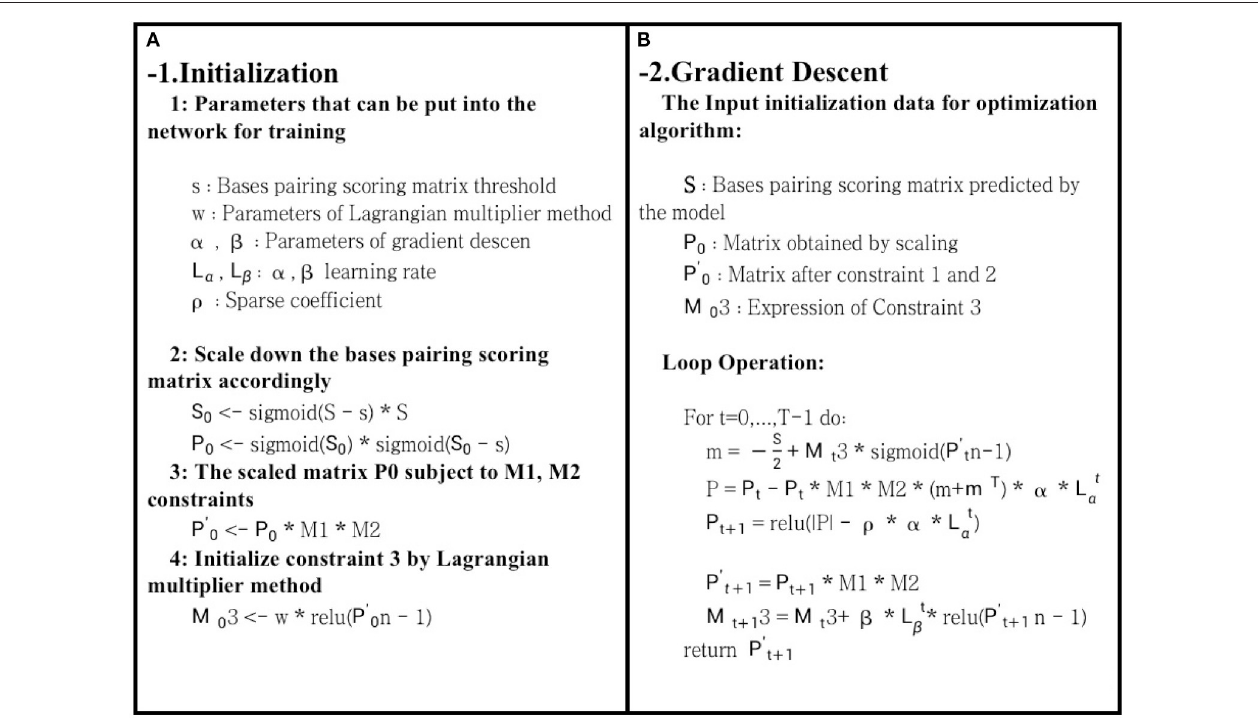
FIGURE 3 | Schematic diagram of bases pairing scoring matrix optimization. The role of (A) is to initialize each parameter and variable during the optimization process. (B) uses the gradient descent optimization algorithm to optimize the bases pairing scoring matrix. Finally, it returns a two-dimensional matrix that meets the hard constraints of RNA secondary